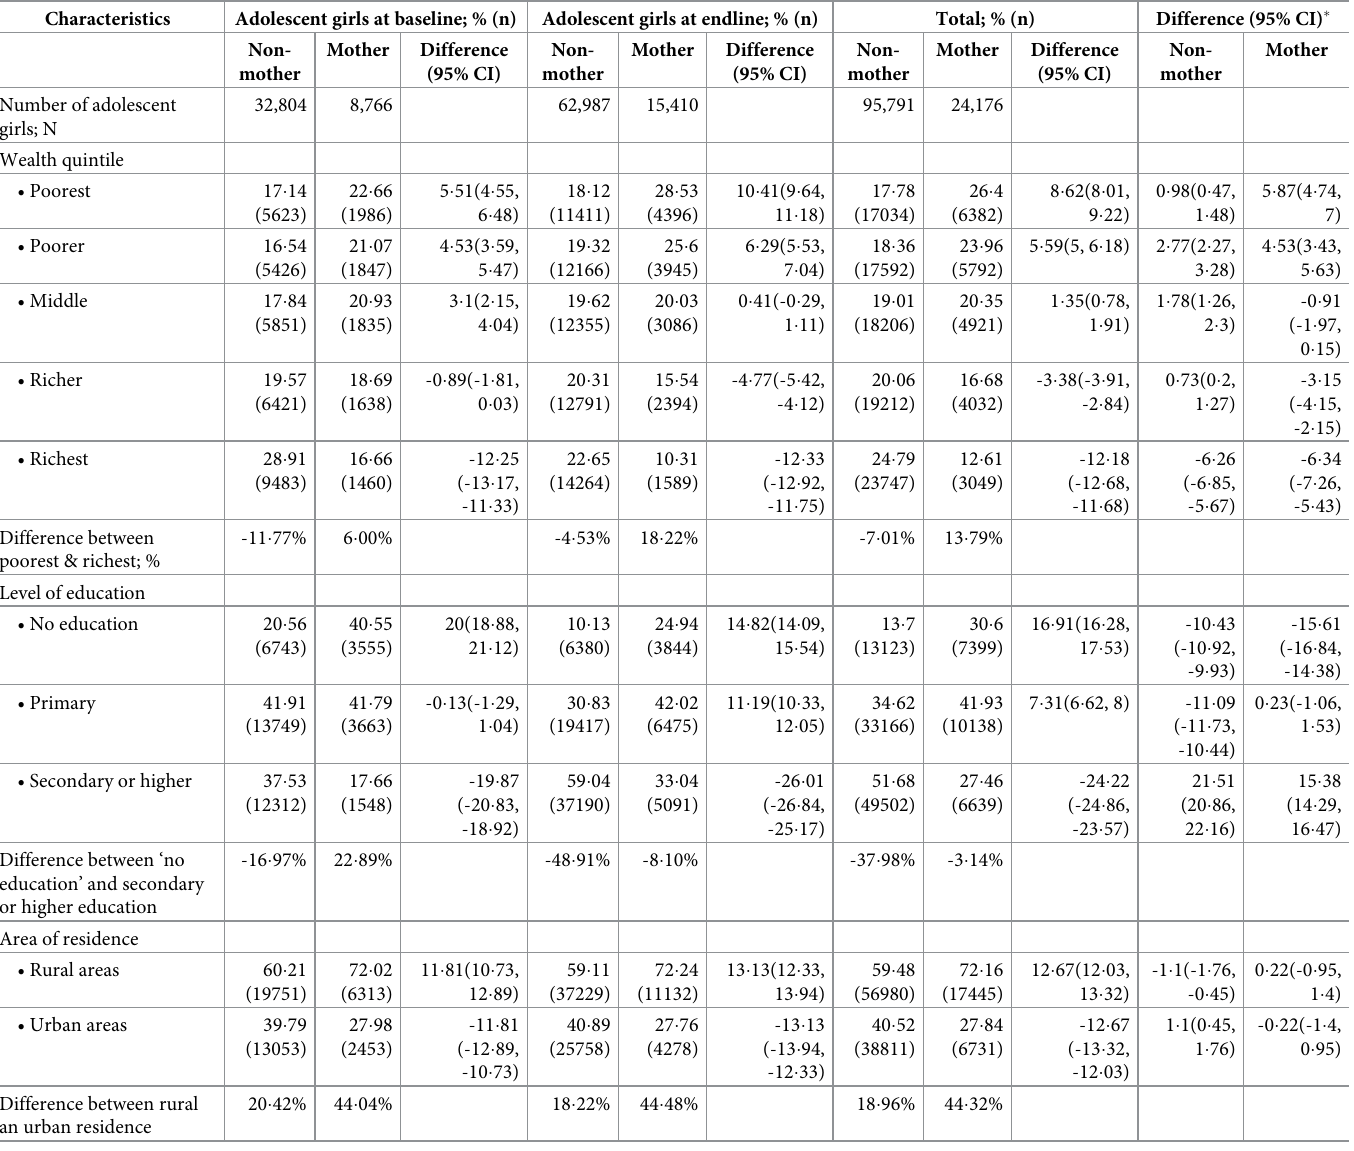
Table 1. Distribution of social risk factors between adolescent mothers and non-mothers in LMICs.